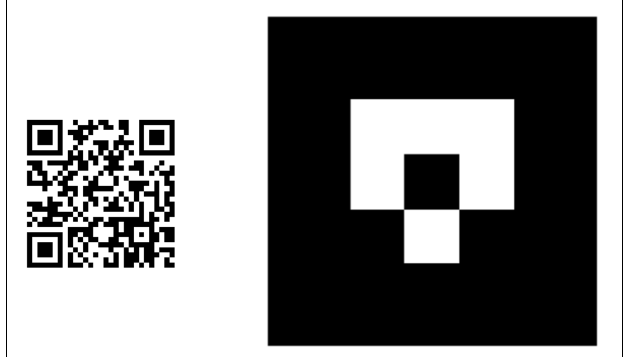
FIGURE 6 | QR code linking to the web app for Augmented Reality (AR) visualization of the 3D model of the skull D64. Instructions: Scan the QR code on the left; open the link; allow the browser to access the camera of your device; point the camera toward the marker (on the right); and wait for the model to load (up to 10 seconds). It is possible to turn the device around the marker (or to move the marker) to see different parts of the model. Best visualization performances can be achieved by printing the markers, rather pointing at them on screens. Refer to Supplementary Material for common issues.